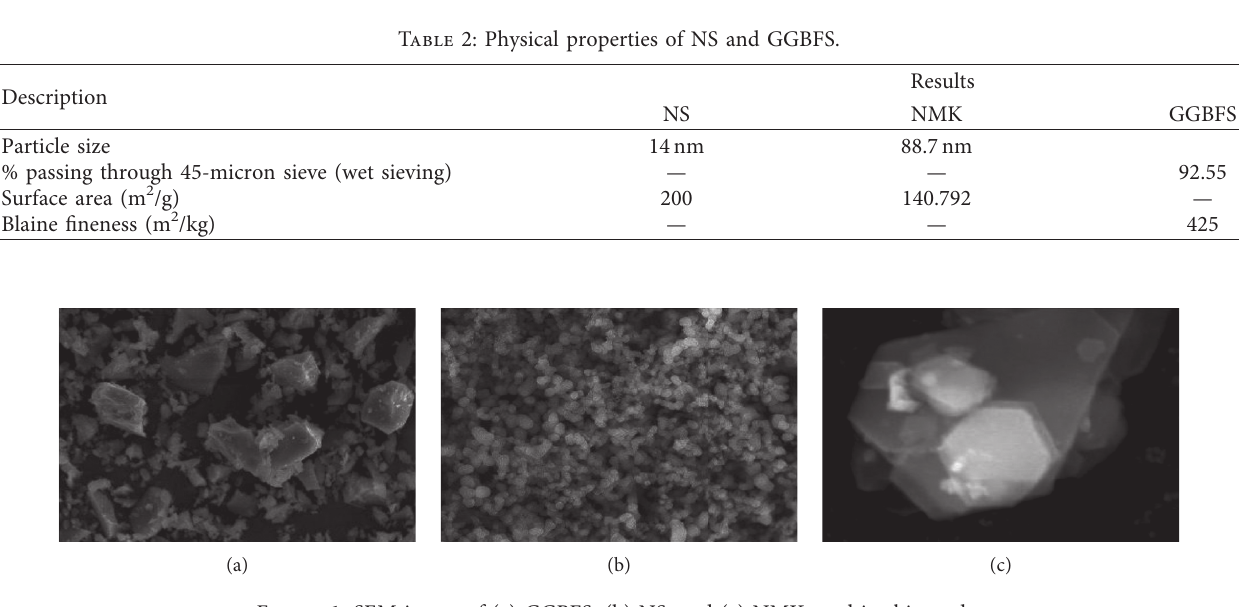
Figure 1: SEM image of (a) GGBFS, (b) NS, and (c) NMK used in this study.